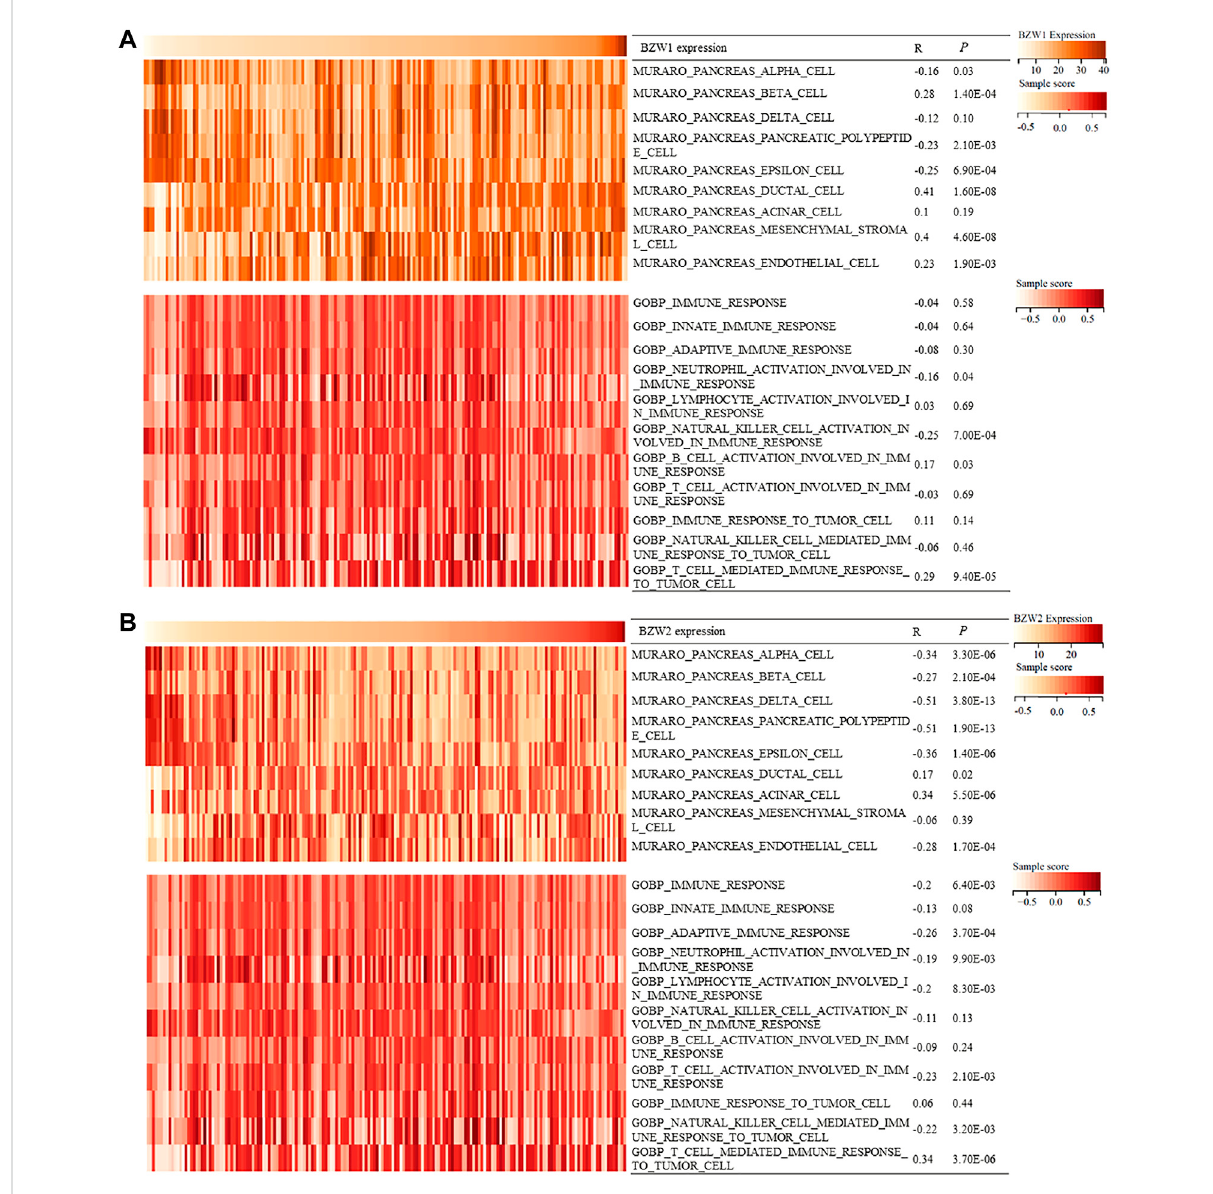
FIGURE 7 Heatmap showed BZW1/2 expression and enrichment scores of pancreatic cells and immune responses about each sample in each TCGA sample. (A) Correlation analyses between BZW1 expression and pancreatic cell or immune response enrichment scores. (B) Correlation analyses between BZW2 expression and pancreatic cell or immune response enrichment scores.